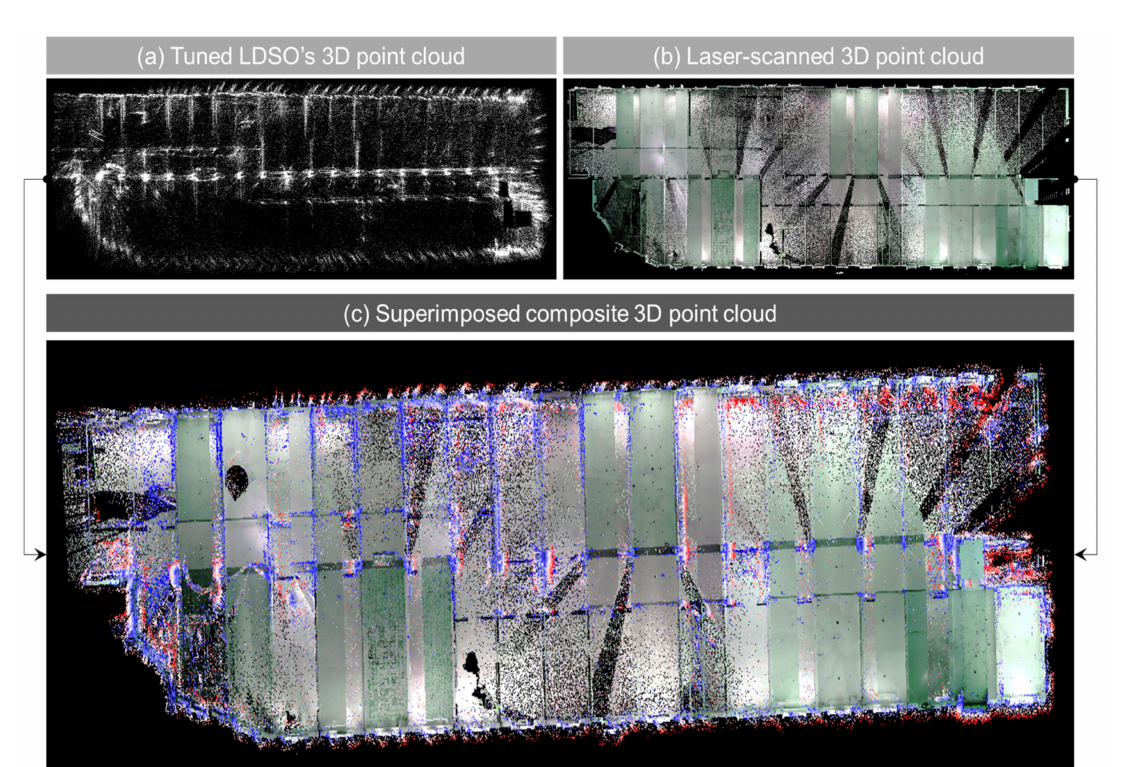
Figure 8. Registration of the tuned LDSO’s 3D point cloud to laser-scanned ground